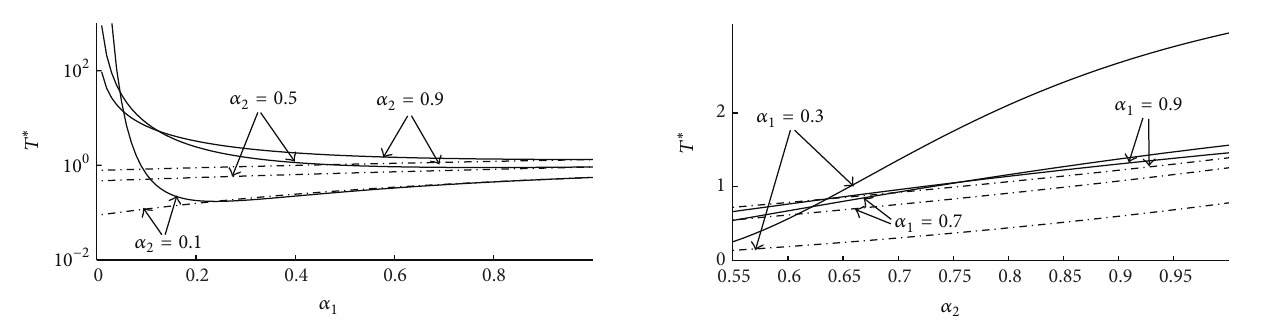
Figure 15: The dependencies for minimal control time from 𝛼 2 at different values of 𝛼 1 for 𝑝 󸀠 = 2 . Logarithmic scale used for ordinates.